Question: What does this figure show? Answer in one sentence.
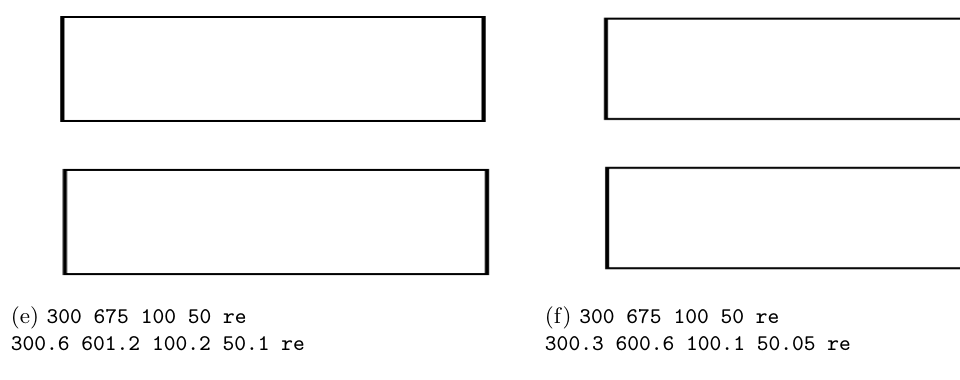
Answer: re Operator - control, 10%, 1%, 0.5%, 0.2% 0.1% (0.2%)